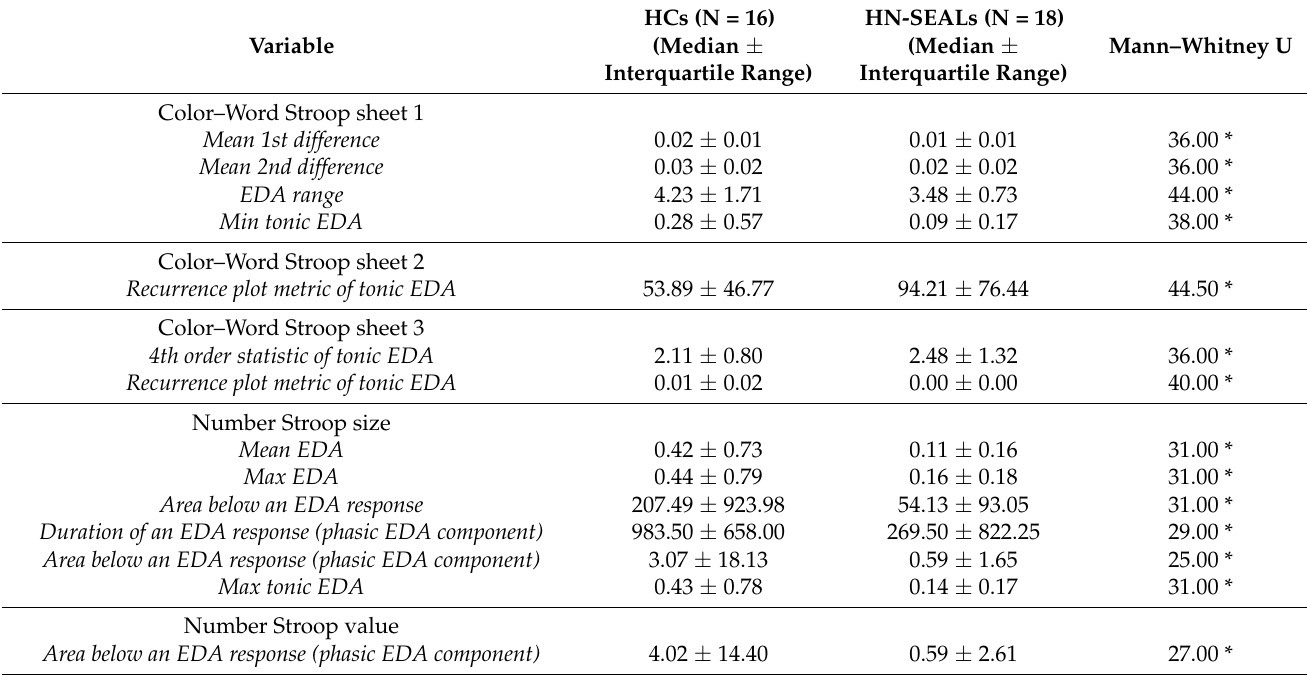
Table 6. Mann–Whitney U test for equality of electrodermal activity mean values during cognitive tasks between HN-SEALs and